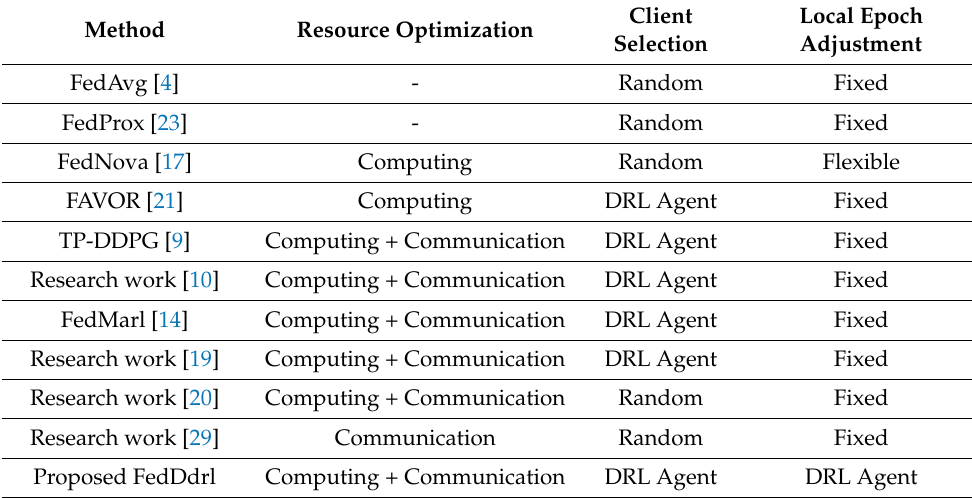
Table 1. Features of existing FL and DRL-based FL